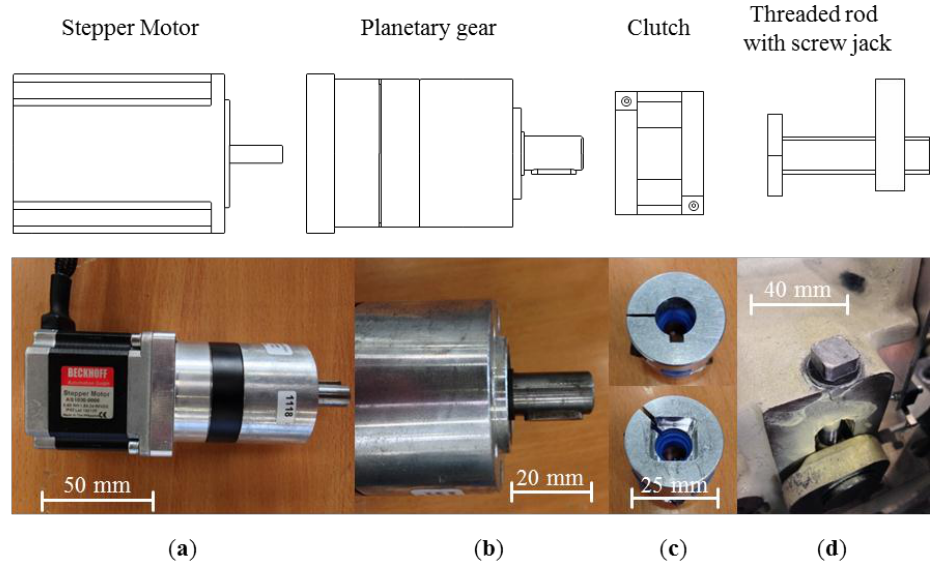
Figure 5. Drive train of the automatized vertical warp stop motion positioning consisting of